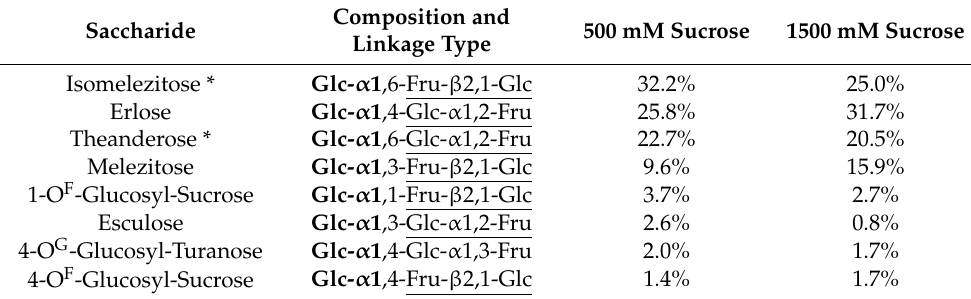
Table 2. Trisaccharide proportions produced from 500 mM or 1500 mM sucrose by the Ba AG2. The sugar in each trisaccharide in bold was used for integration. The sucrose moiety in trisaccharides is